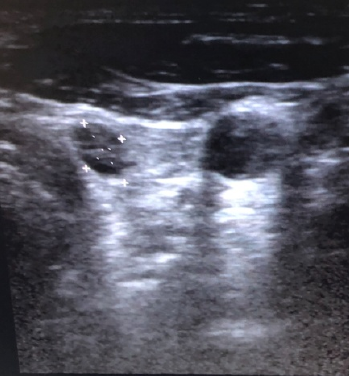
Figure 1. Thyroid ultrasound revealing a left lobe hypoechoic thyroid nodule .